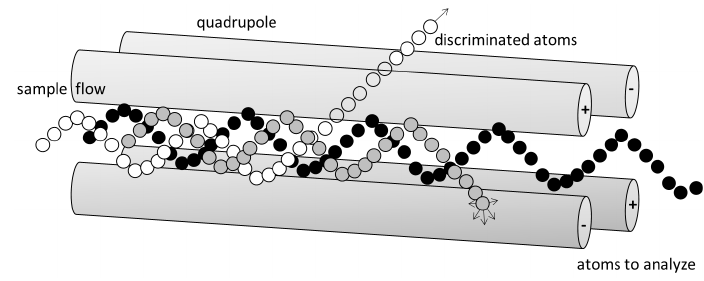
Figure 7. Quadrupole filter (adapted from [70–72]).